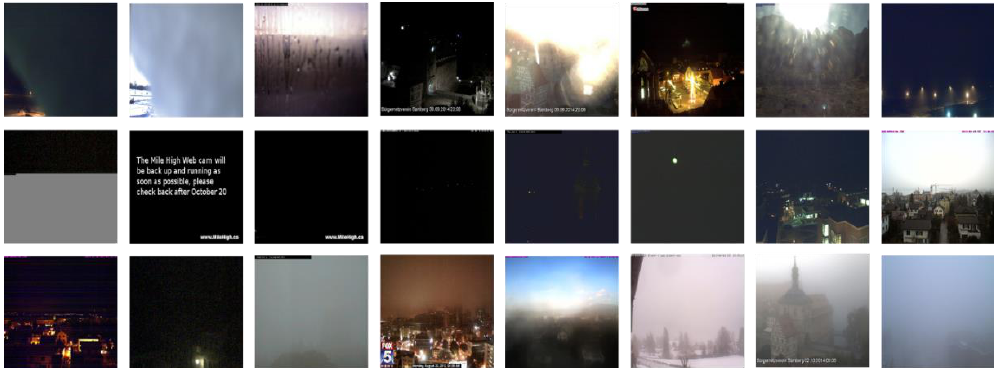
Figure A1. The practical views from the Perseverance, Opportunity, and Spirit Mars rover of the NASA. ( a ) refers to the view of left Mastcam-Z Camera captured by the Perseverance [56]. ( b ) refers to the view of right Mastcam-Z camera captured by the Perseverance [56]. ( c ) refers to the view of rear hazard avoidance camera captured by the Perseverance [56]. ( d ) refers to the north edge of the “Home Plate” plateau captured by the Spirit [73]. ( e ) refers to the rim of “Erebus Crater” captured by the Opportunity [73]. ( f ) refers to the Meridiani Planum region captured by the navigation camera of the Opportunity [73].